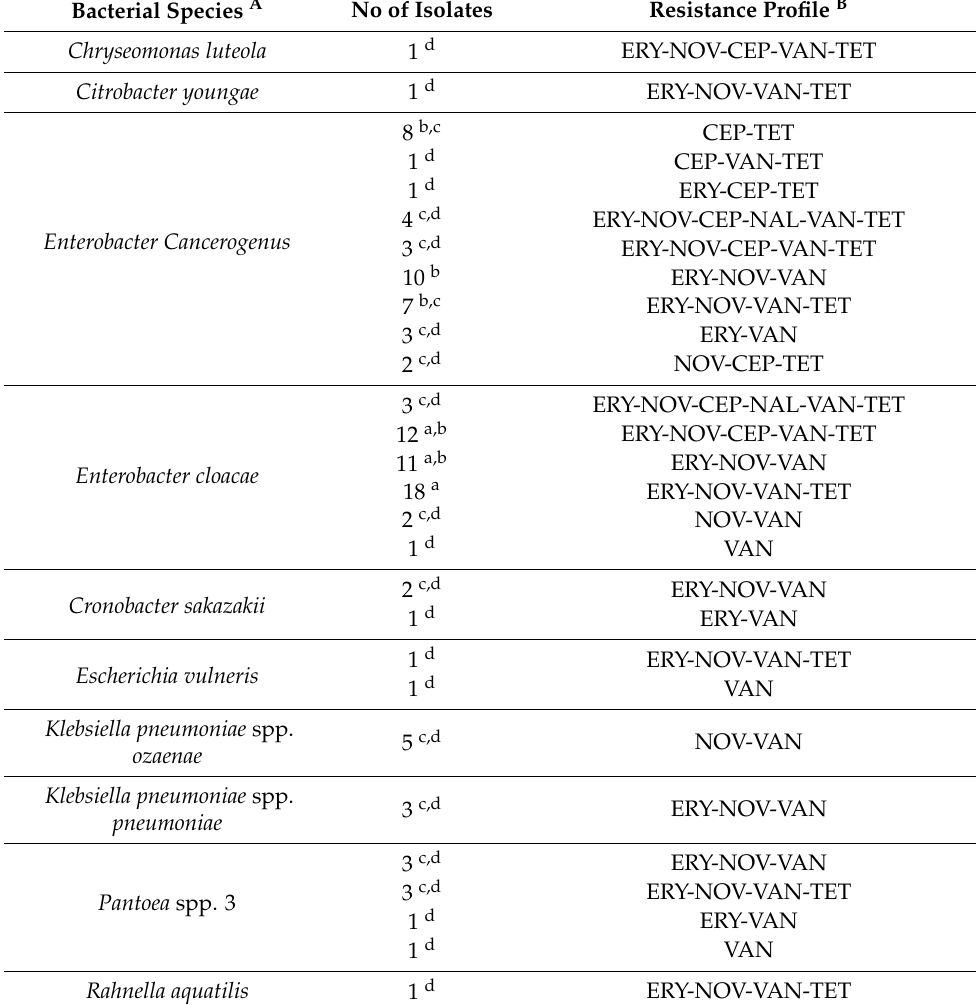
Table 3. Antibiotic Resistance Patterns of Enterobacteriaceae in Nuts and Seed